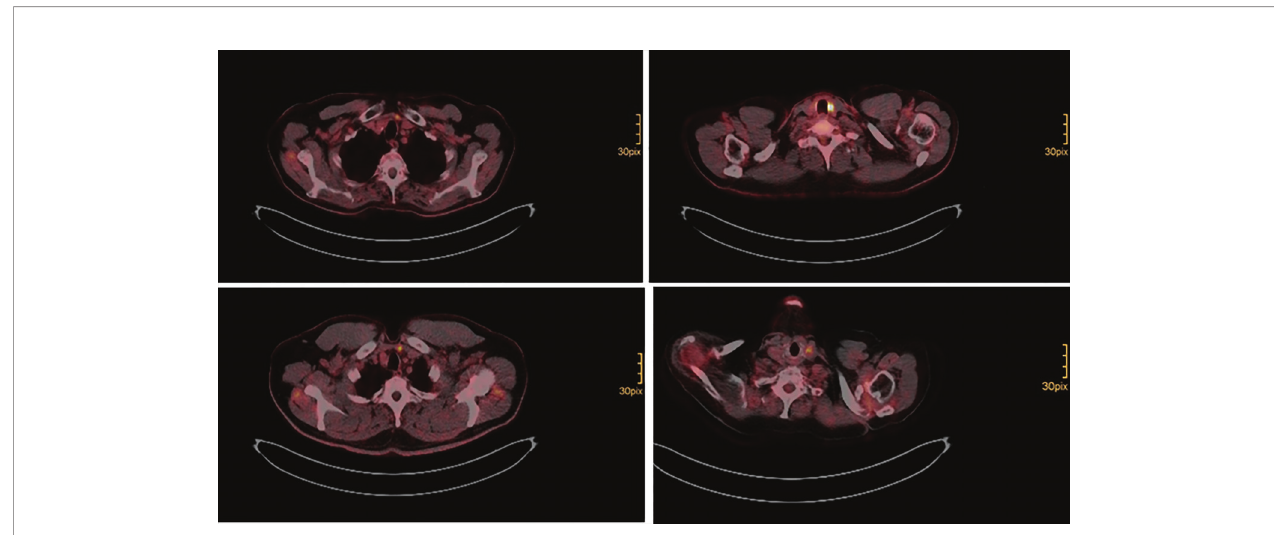
Table 2 summarizes the clinic-pathological features of patients undergoing second-line surgery for isolated cervical relapse without distant metastasis. Tg, Thyroglobulin. None of these patientshadpathologicTgantibodies.V=angioinvasions(V0=absent,V1=microscopic,V2=macroscopic).Endresultswereclassi fi edinexcellent,indeterminate,biochemicalincomplete and structural incomplete response according to Pitoia and Jerkovich (20).